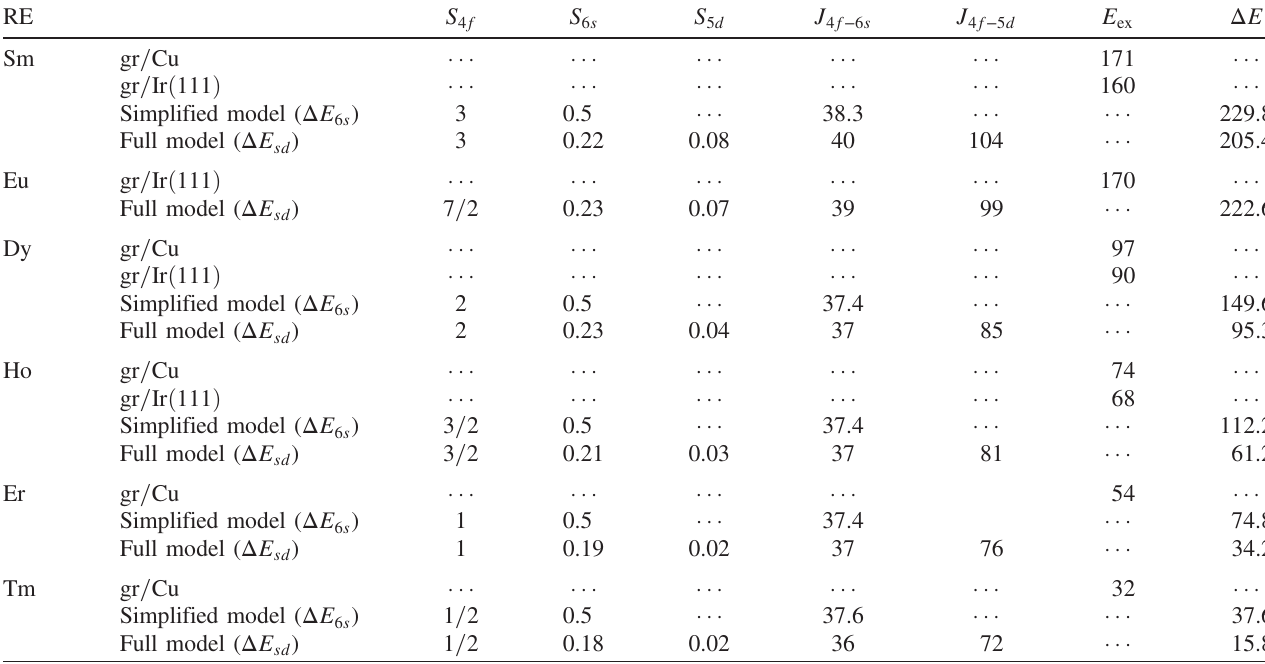
from ex ¼ 2 J Δ S 4 f − 6 s 6 s S 4 f , with J 4 f − 6 s from Ref. [18] and s ¼ 0 ) are not included. All energies are in meV. f